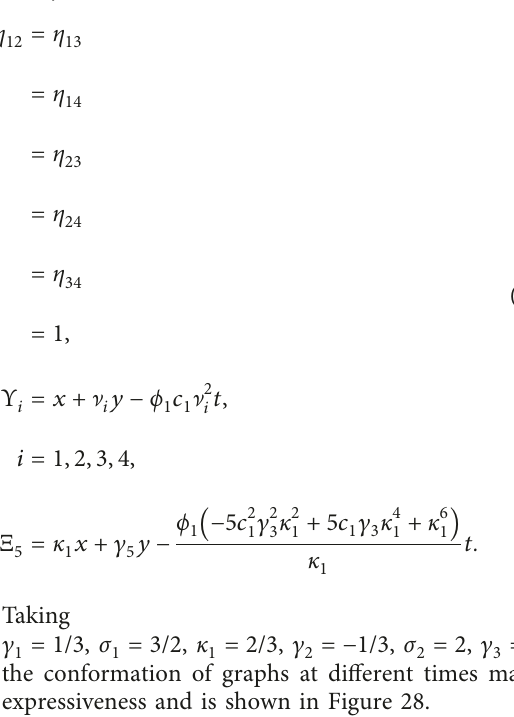
� 1 , c � 1/10. ( f 1, f 4) t � − 30. ( f 2, f 5) t � 0. ( f 3, f 6) t � 30. 0 1